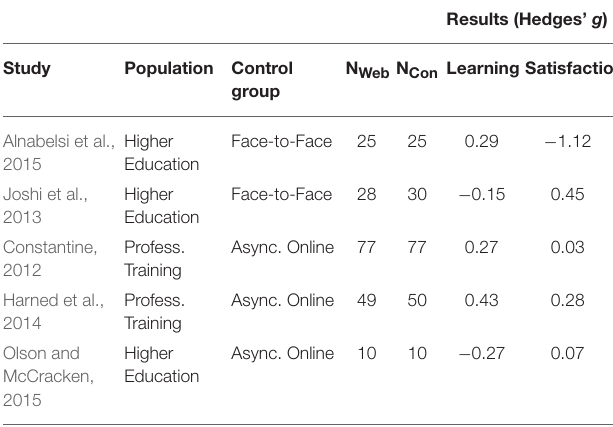
TABLE 4 | Summary of single-study